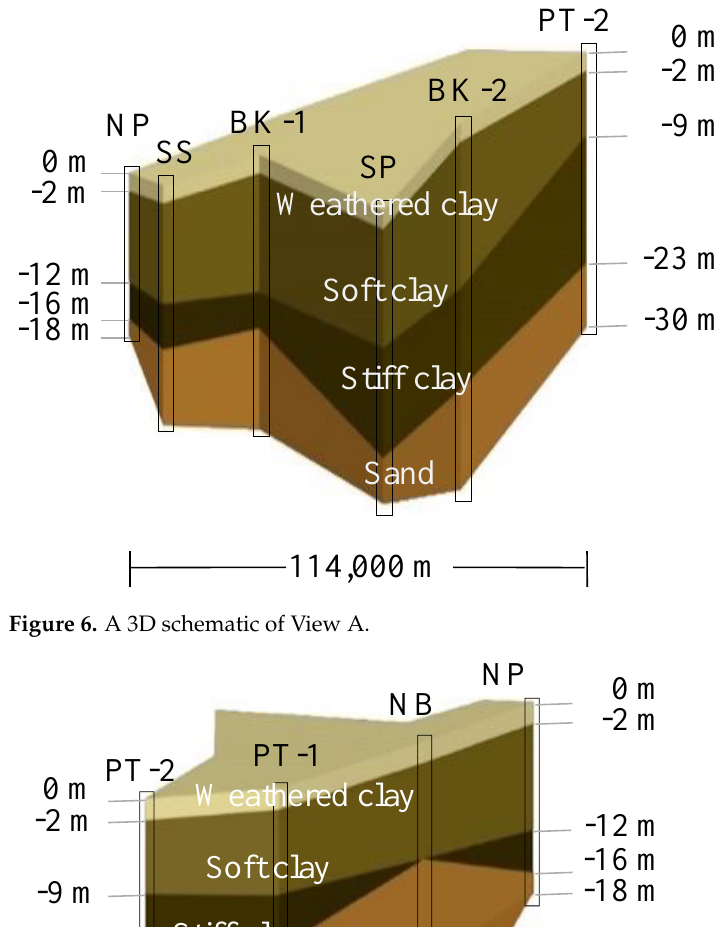
Figure 5. Top view layout of study area.